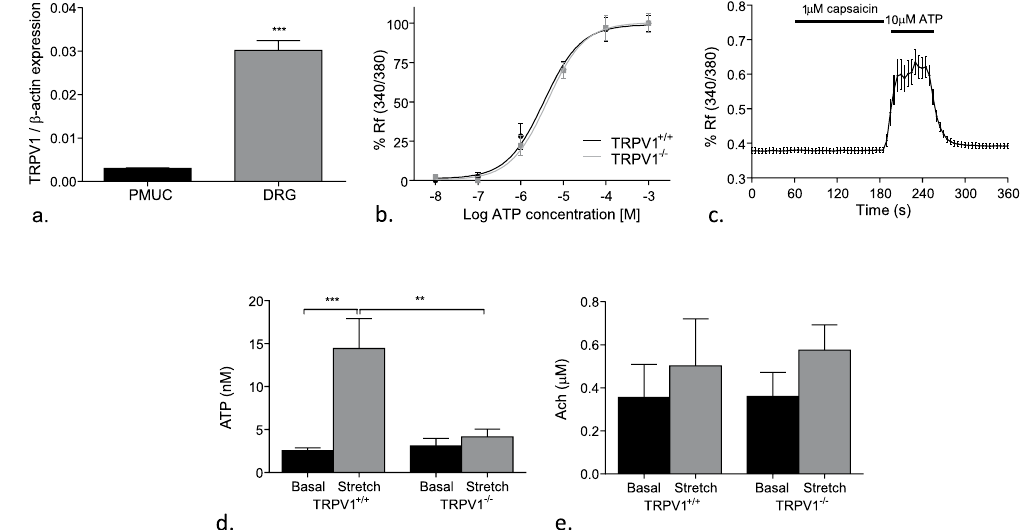
Figure 5. The effect of TRPV1 on urothelial responses to P2X stimulation. ( a ) Relative expression of TRPV1 in PMUC and pelvic DRG neurons;; Data are mean ± SEM, two tailed un-paired t-test *** p ≤ 0.001 (n = 3); ( b ) normalised concentration response curve of PMUC intracellular calcium to ATP in TRPV1 + / + and TRPV1 − / − mice (n = 6); ( c ) change in intracellular calcium levels of PMUCs to capsaicin and ATP; ( d ) intraluminal ATP and ( e ) acetylcholine release from TRPV1 + / + and TRPV1 − / − mouse bladders; Data are mean ± SEM,